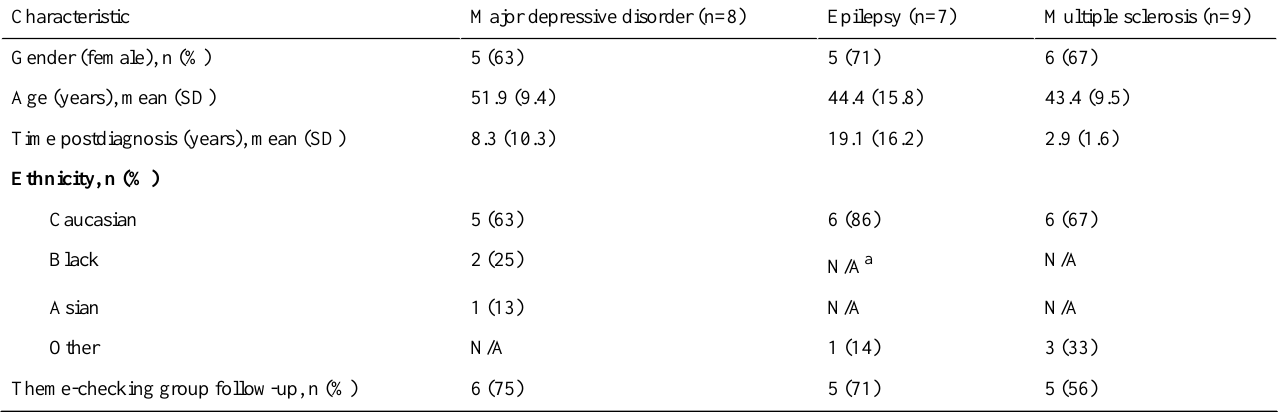
Table 2. Sample characteristics across the three health